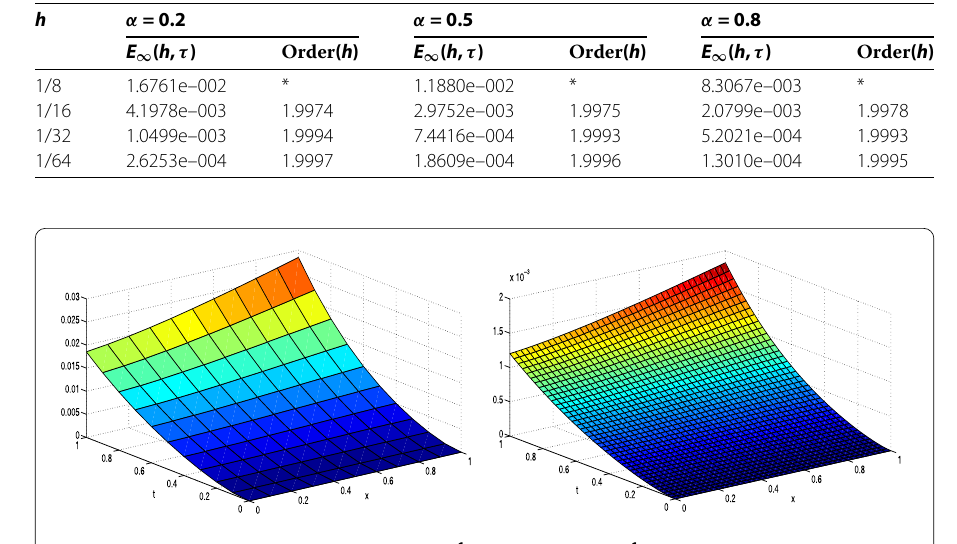
Table 2 The numerical convergence orders in spatial direction with τ =